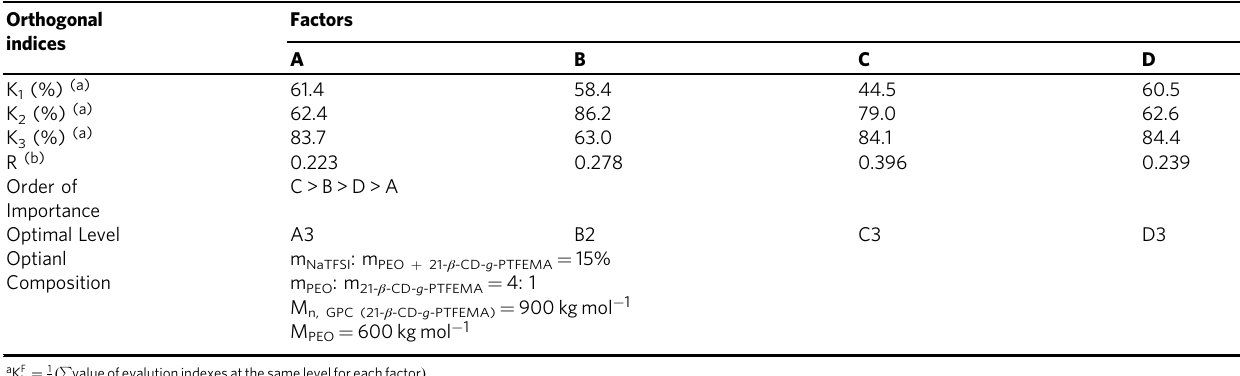
experiments on AS-LMBs and AS-SMBs. The commonalities between the two types of FMC-ASPEs for different metal batteries were the anion of the salts and the molecular weight of 21- β -CD- g - PTFEMA, indicating that the salts containing the TFSI − anion and the 900 kDa molecular weight 21- β -CD- g -PTFEMA were conducive